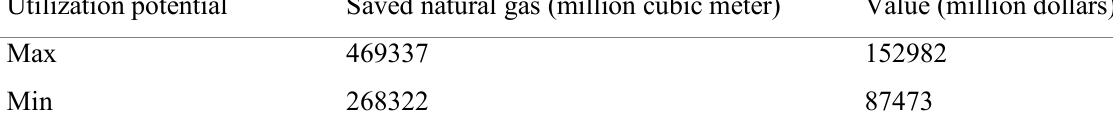
Table 3. Effect of global wind energy utilization on fossil fuel consumption cost reduction in